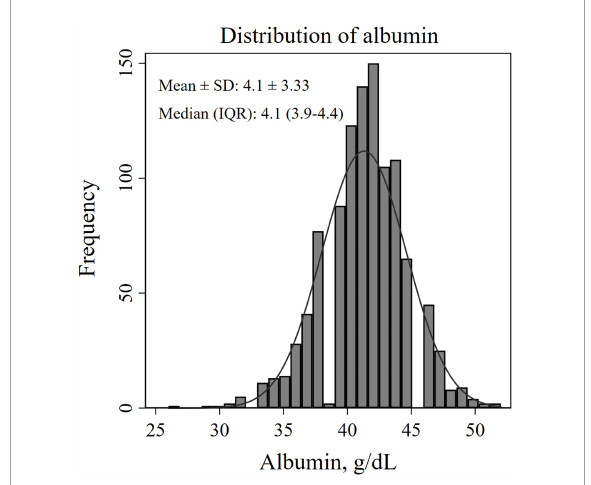
FIGURE1 Histogram for estimating the distribution of albumin levels.